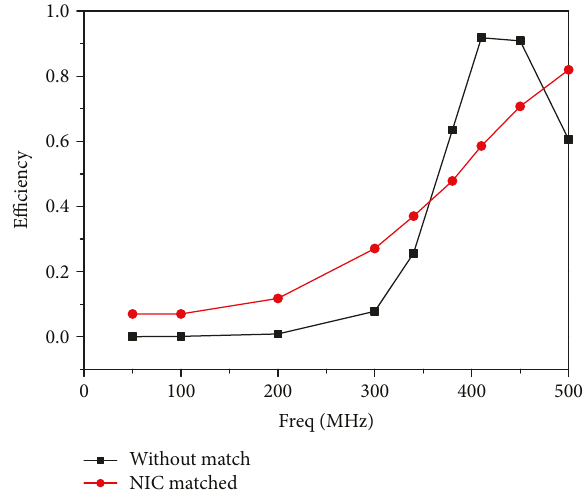
Figure 12: E ffi ciency of the NIC matched and unmatched